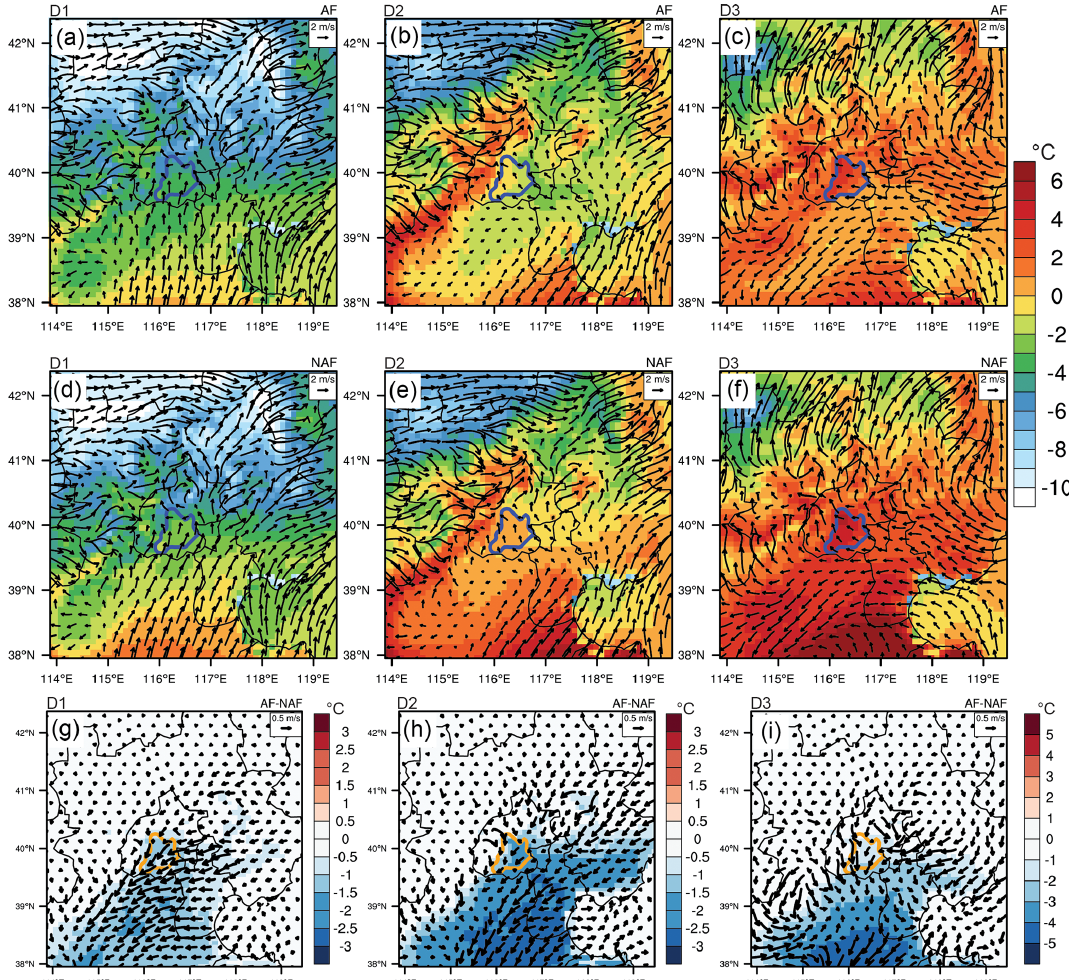
Figure 6. Simulated 2m air temperatures and 10sm wind fields in AF (first row), NAF (second row) and differences between AF and NAF (third row) on D1 (first column), D2 (second column), and D3 (third column). The areas within the blue (a–f) and orange (g–i) line are urban areas of